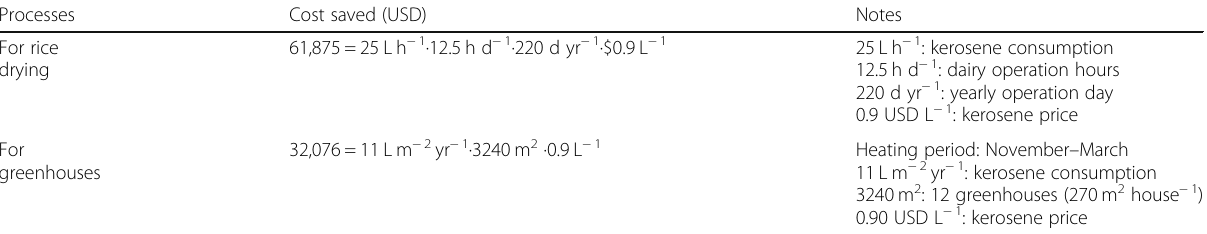
Table 4 Cost savings from reducing kerosene consumption in Route 1 Processes Cost saved (USD)